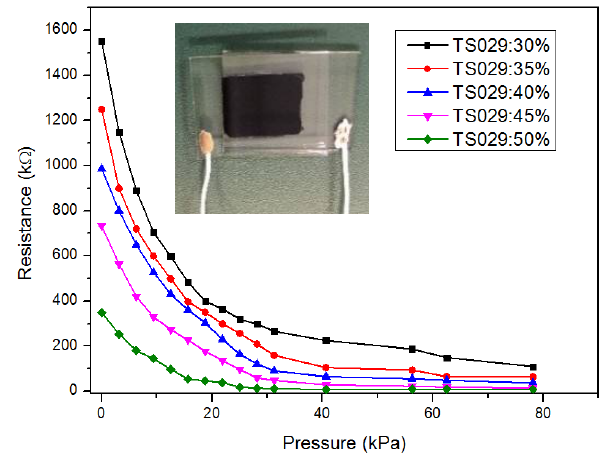
Figure 7. The observed resistance of the pressure sensors with different concentration of TS029 in PDMS in the pressure range of 0–80 kPa.